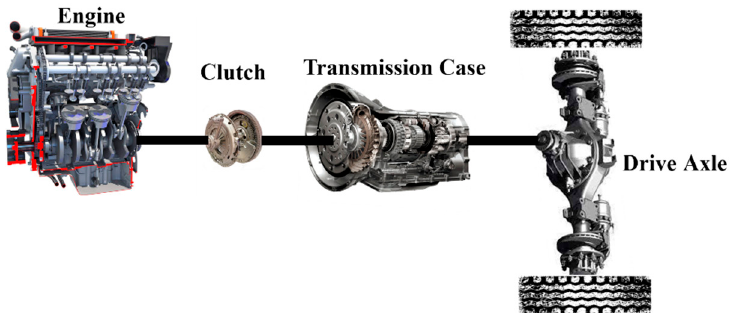
Figure 1. The schematic of the truck configuration. Table 1. Vehicle parameter information.